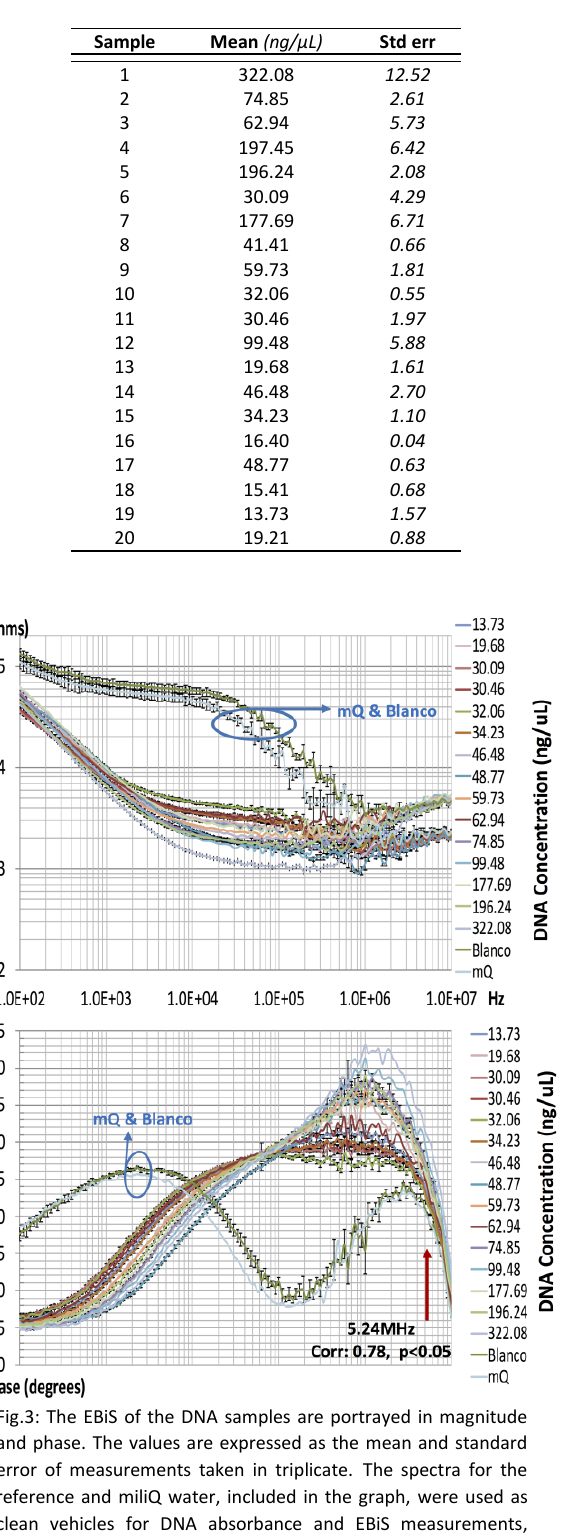
Table 1. DNA was quantified by absorbance at 260 nm. The mean value and the corresponding standard error is listed for each measurement (made in triplicate).